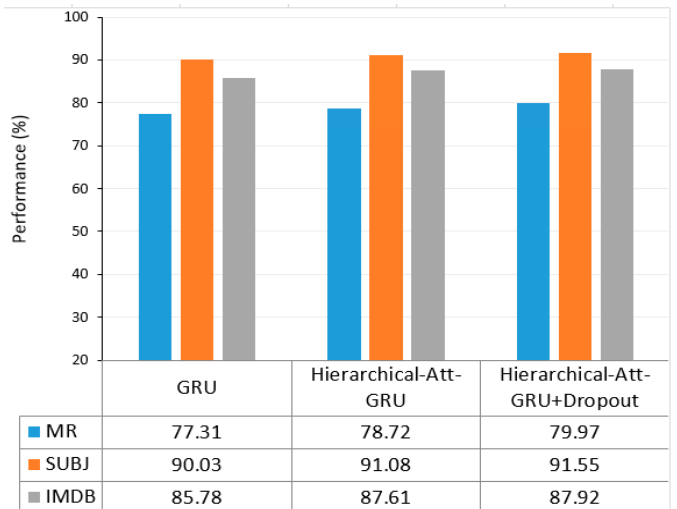
Figure 6. Performance of the GRU-based models on the SUBJ, MR and IMDB